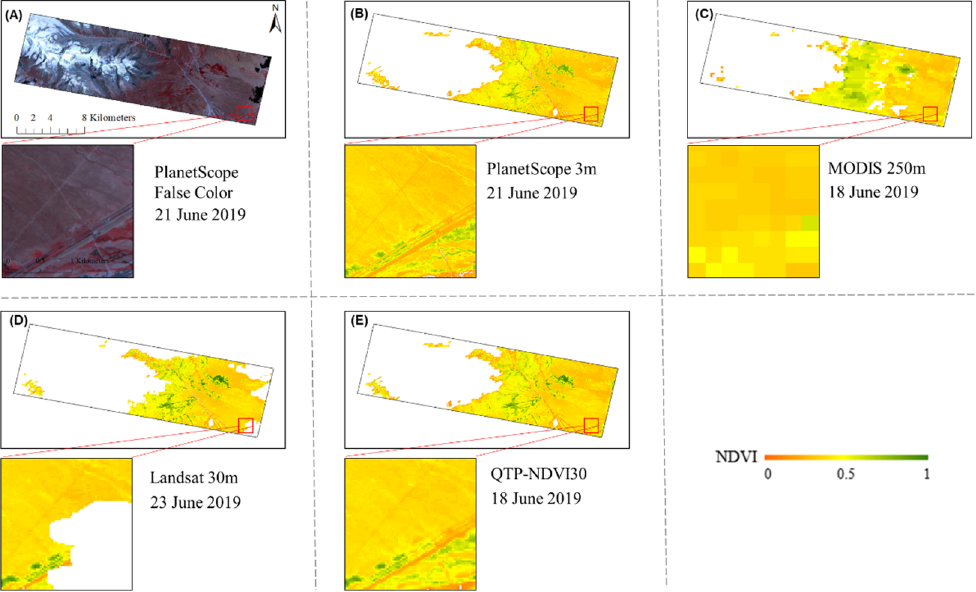
Figure 7. Comparisons of the spatial patterns of the PlanetScope NDVI (3 m), MODIS NDVI (250 m),